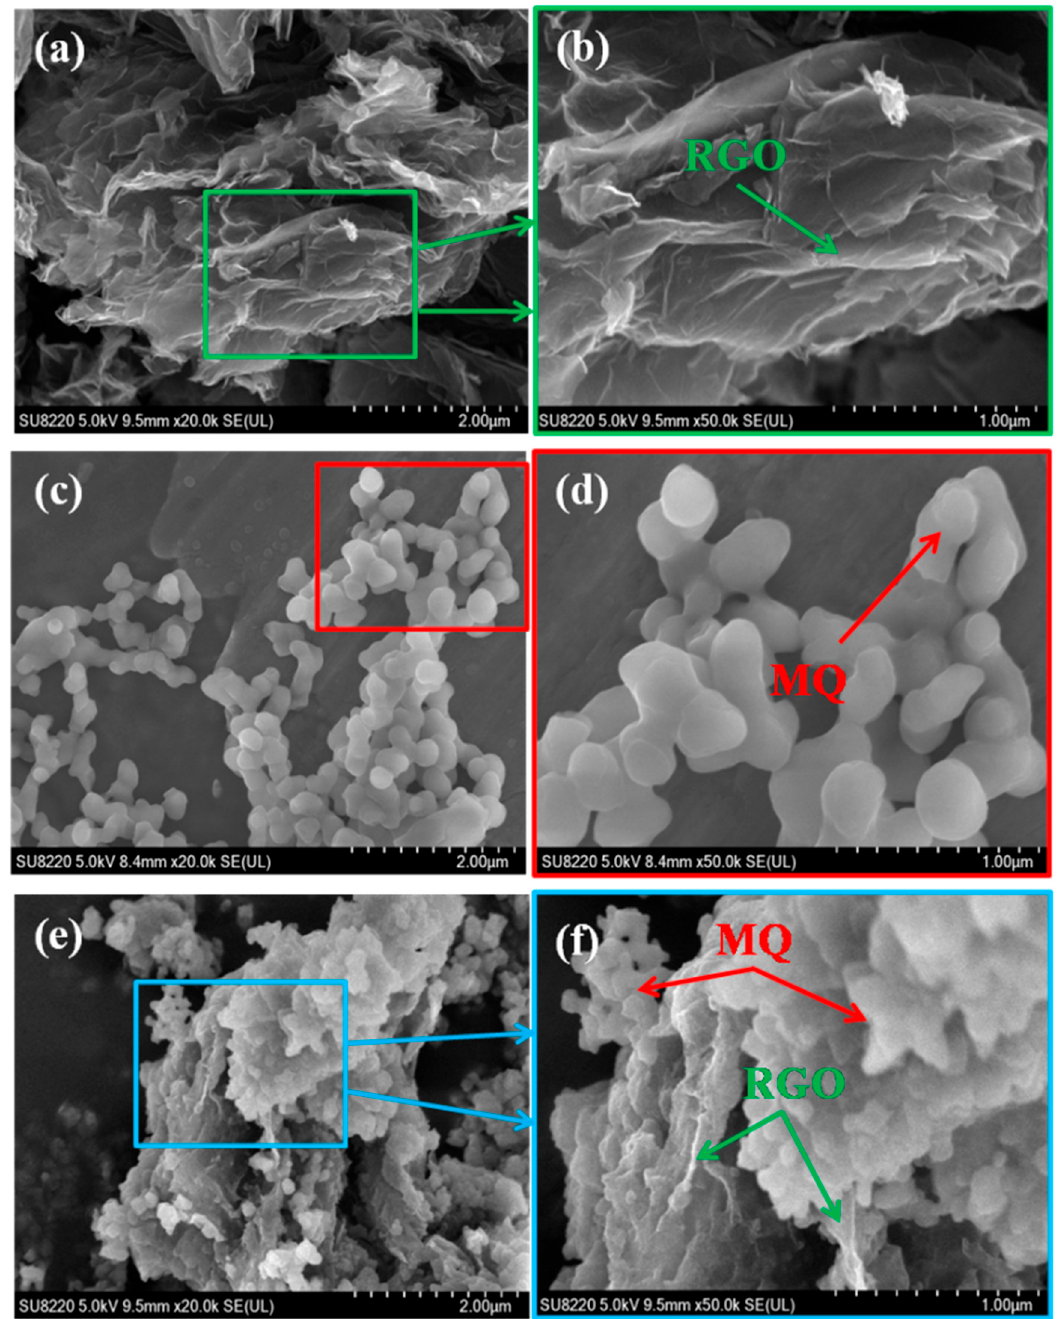
Figure 2. Scanning electron microscopy (SEM) images of ( a , b ) RGO, ( c , d ) MQ and ( e , f ) RGO/MQ at different